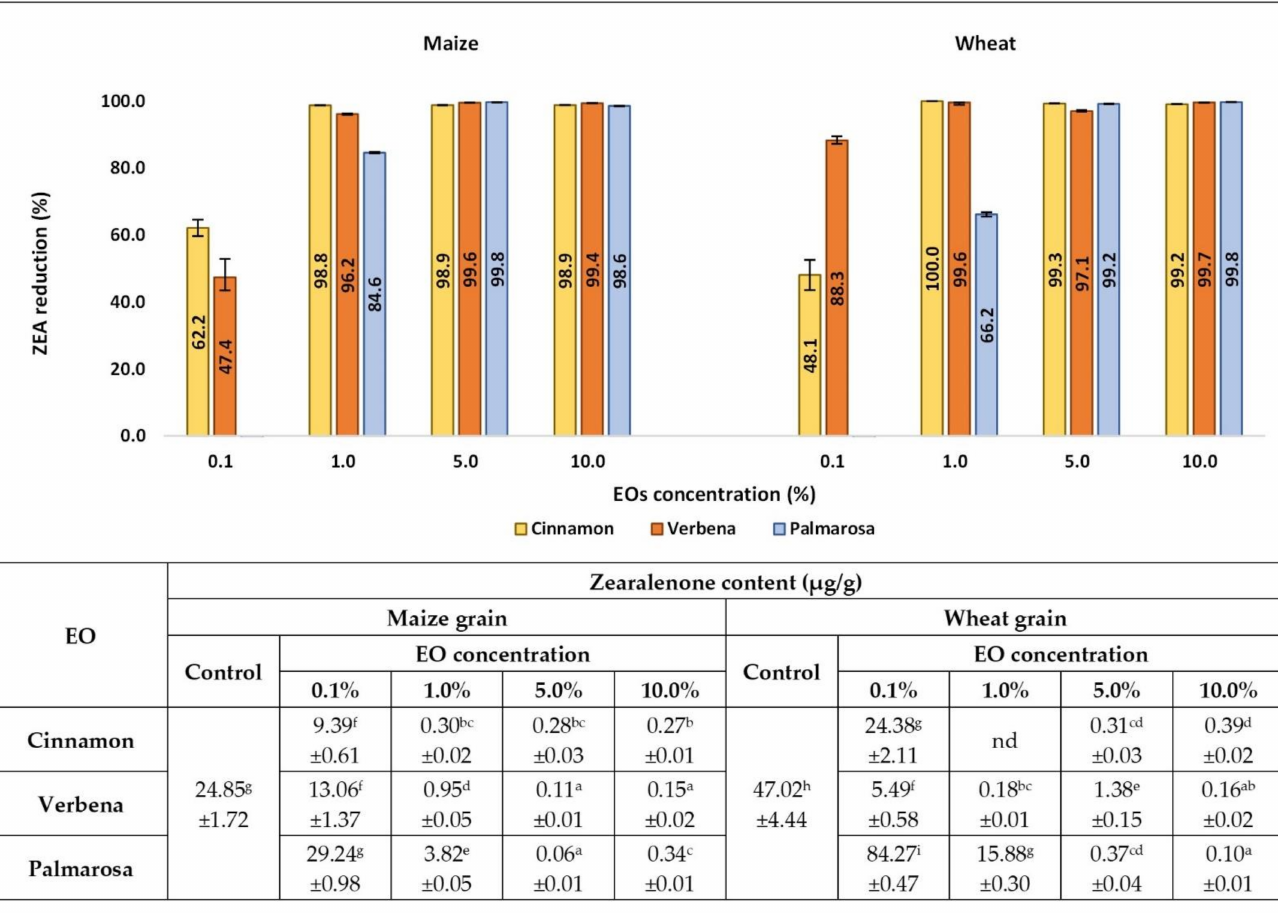
Figure 5. Effects of EOs on ZEA contamination in maize and wheat samples after inoculation with the F. graminearum. nd-not detected, below the limit of quantification (<0.01 µ g/g). Averages with different letters (a–i) for each cereal are significantly different at the p <